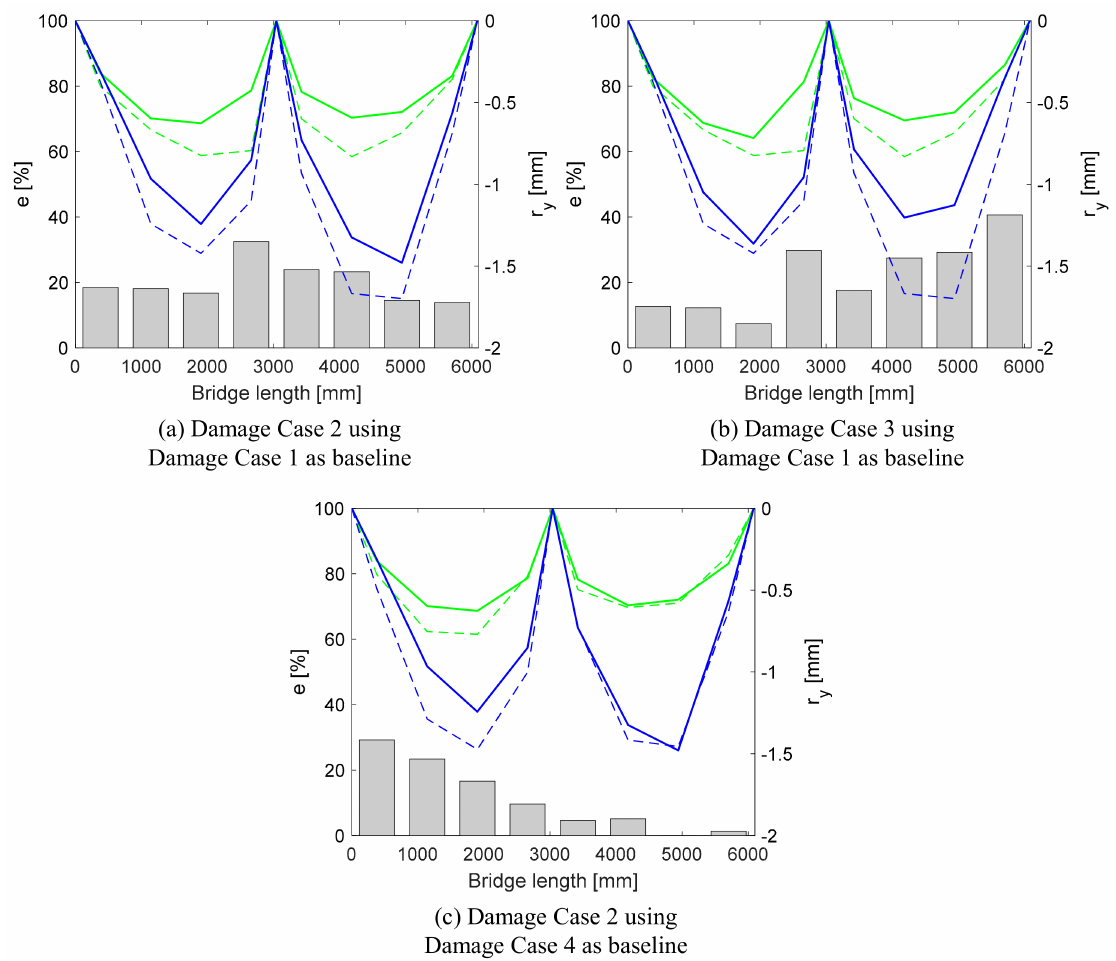
Figure 10. Damage detection using relative changes between different damage cases. The lines and bars describe parameters already introduced in Figure